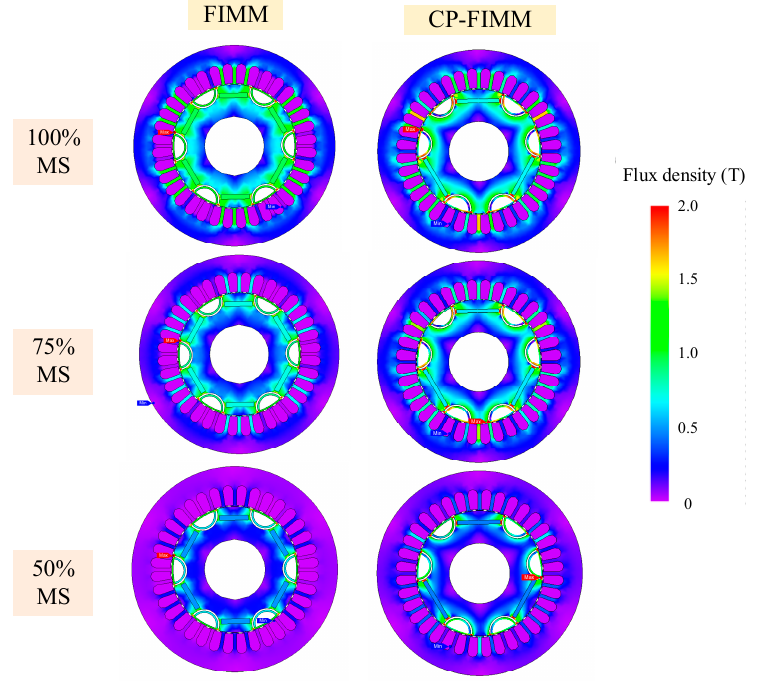
Figure 6. Flux density distributions of the two machines under different MSs.